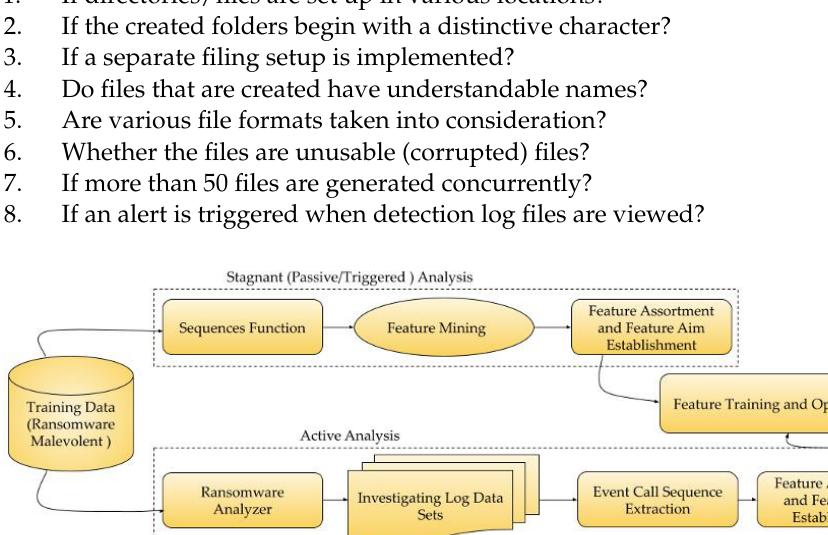
recorded to calculate the average